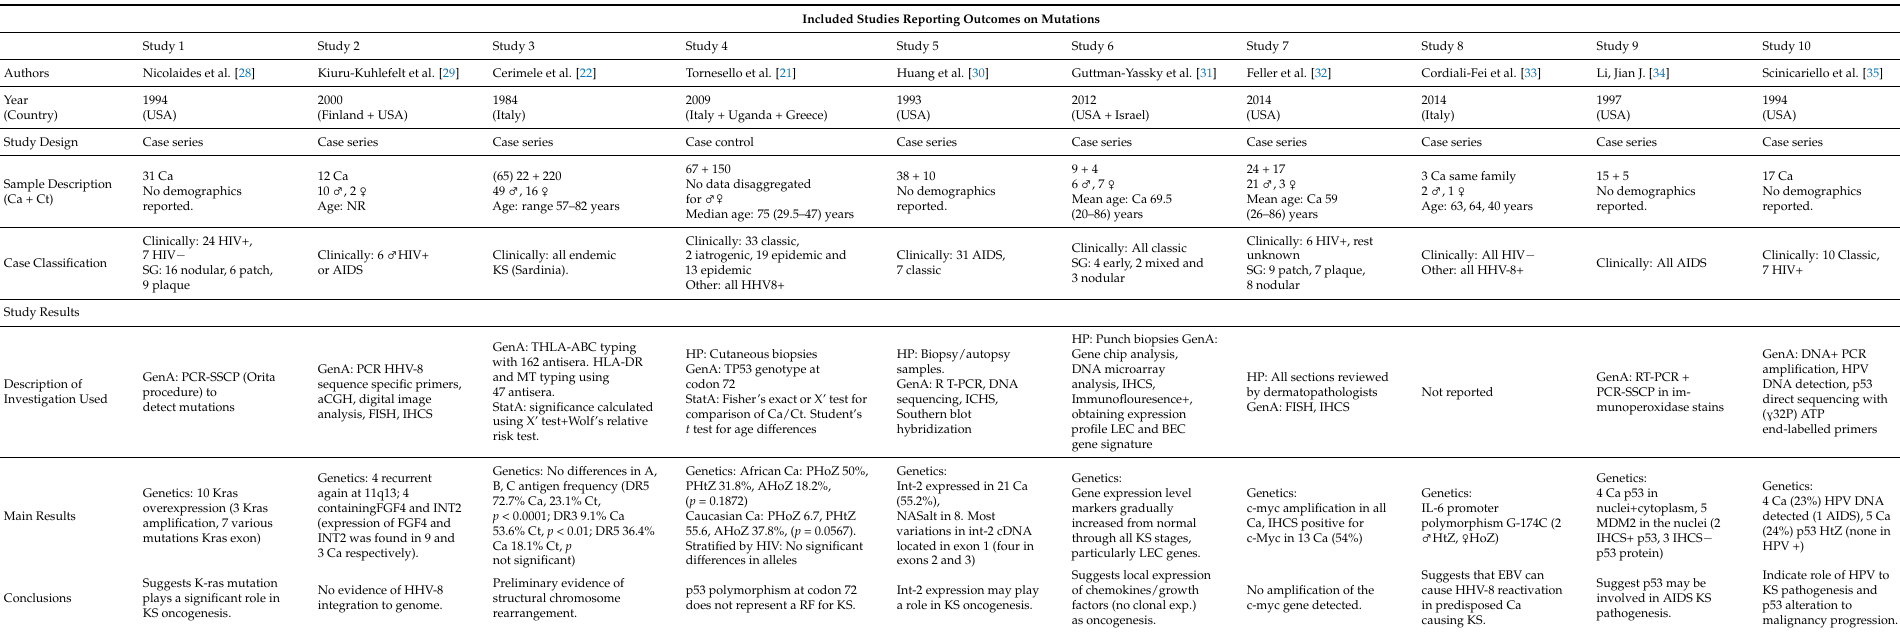
Table 3. Summary of findings: studies reporting on